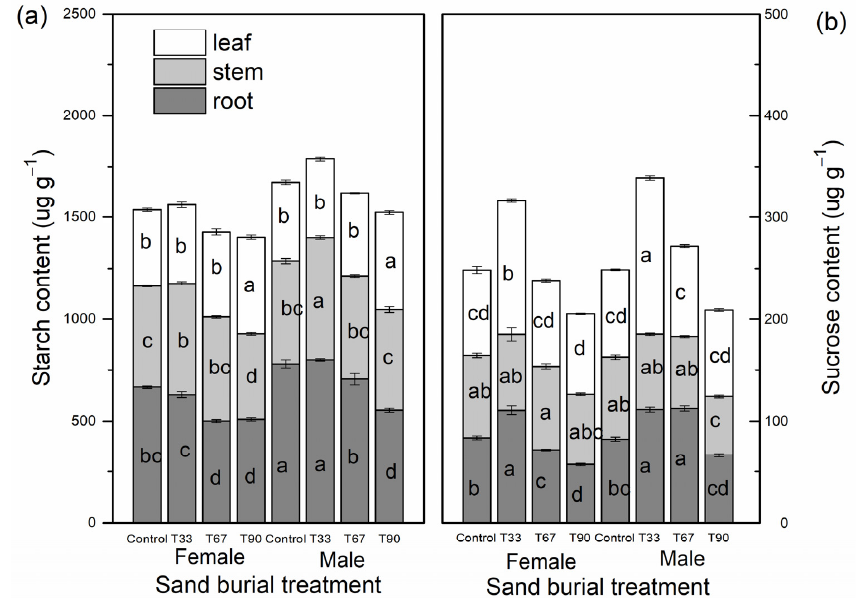
Figure 4. Mean values ( ± SE, n = 5) of carbohydrates of female and male saplings of H. rhamnoides under different sand burial depths. ( a ) Starch content. ( b ) Sucrose content. Different lowercase letters indicate significant differences between sand burial treatments according to Bonferroni’s test ( p < 0.05).